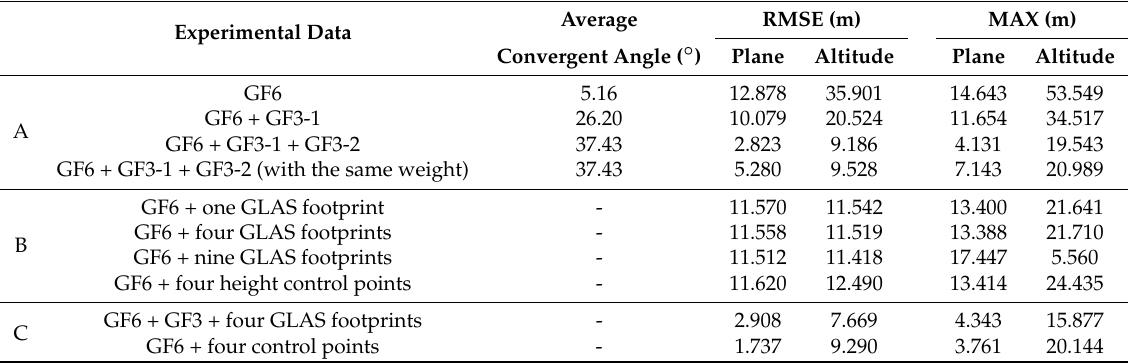
Table 6. Geometric accuracy of GF6, GF3, and GLAS combined